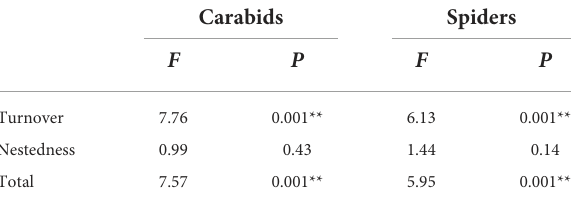
P -values are indicated with asterisks illustrating the power of the levels of significance: “*” ≤ 0.05;“**” ≤ 0.01;“***” ≤